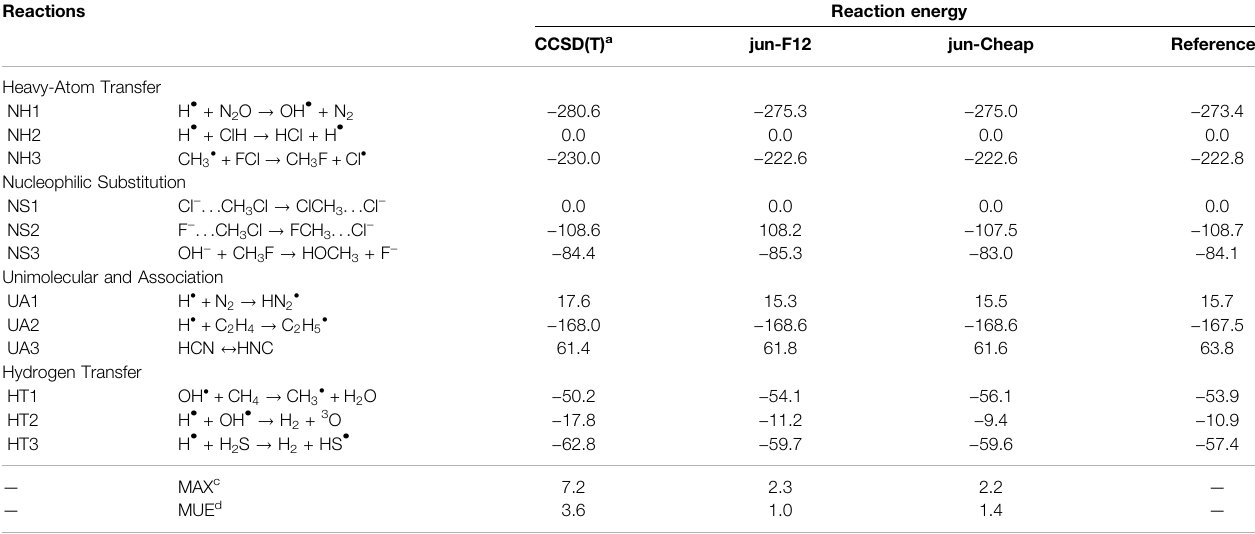
TABLE 1 | Computed reaction energies for NH, NS, UA, and HT reactions from the DBH24/08 database at different levels of theory. All values are in kJ/mol.